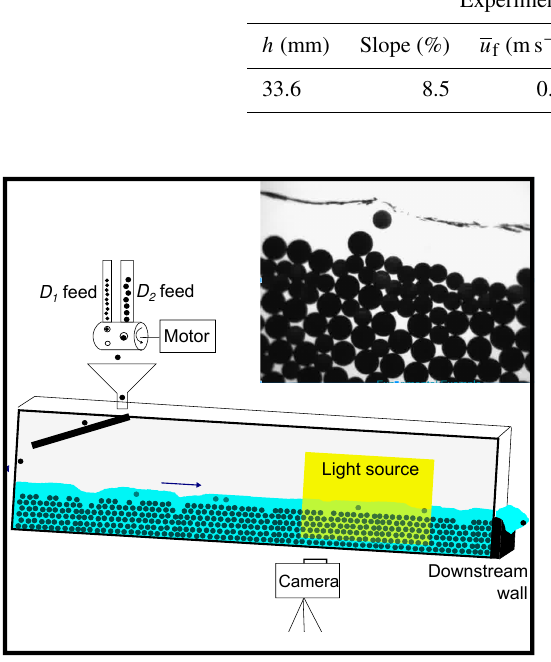
Figure 1. Schematic of the experimental setup. The system is 2.3m long and 20mm wide. This quasi-two dimensional channel is fed at a constant water discharge for all experiments. The slope is kept constant at 6%. The sediment feed is uncoupled from the fluid discharge and is introduced from above using a custom-designed feeder built at the Penn Sediment Dynamics Laboratory (PennSeD) laboratory. A viewing window of approximately 35cm wide by 30cm high is selected two-thirds of the way down the flume. The window is backlit and the resulting images can be seen in the figure inset.